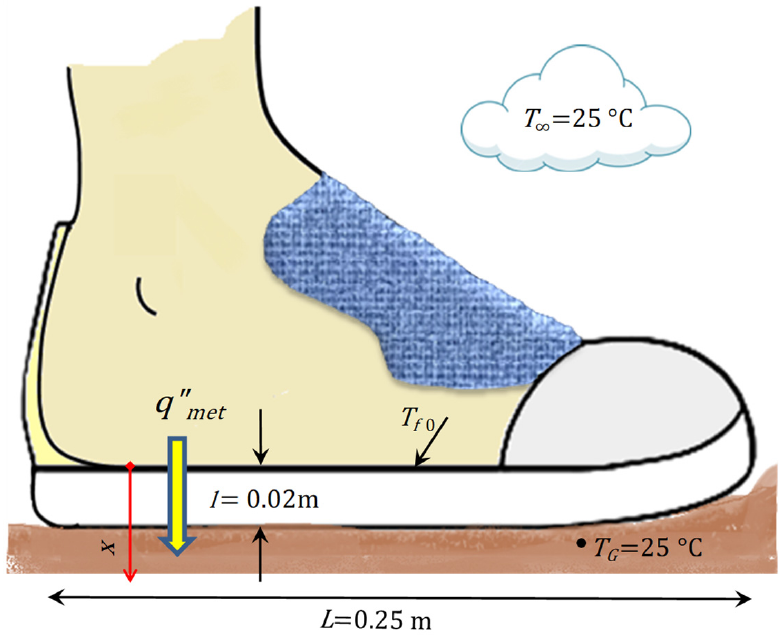
Figure 4. Thermal conditions for 10 min rest in the experiment.